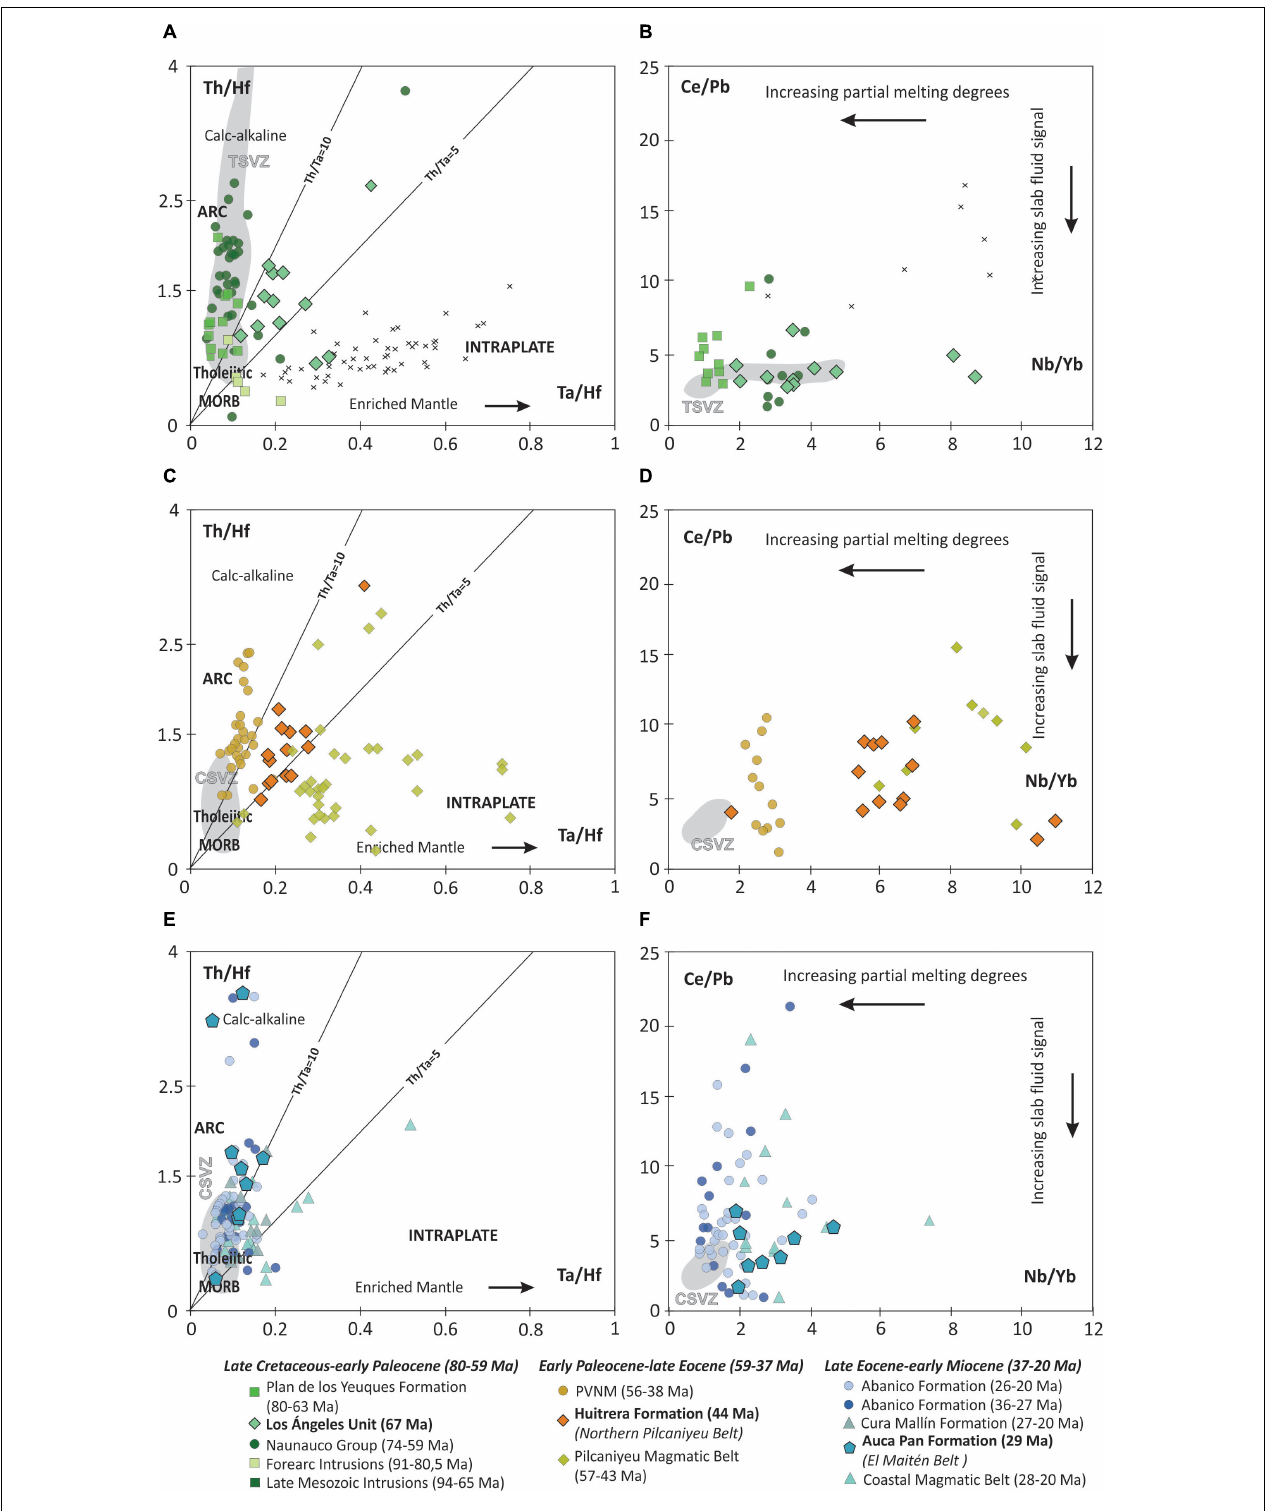
FIGURE 11 | (A,B) Th/Hf vs. Ta/Hf and Ce/Pb vs. Nb/Yb for Late Cretaceous-early Paleocene magmatic units along the Southern Central Andes. (C,D) Th/Hf vs. Ta/Hf and Ce/Pb vs. Nb/Yb for early Paleoceno-late Eocene magmatic units along the Southern Central Andes. (E,F) Th/Hf vs. Ta/Hf and Ce/Pb vs. Nb/Yb for late Eocene-early Miocene magmatic units along the Southern Central Andes. Gray crosses correspond to the Neogene Main and Post-Plateau lavas from Patagonia retroarc (Gorring and Kay, 2001; Guivel et al., 2006). For references to the data sources, see details in the text (references in section Compiled Arc-Like Andean Dataset). TSVZ corresponds to the Transitional Southern Volcanic Zone (34.5–38 ◦ S) while CSVZ corresponds to the Central Southern Volcanic Zone (38–43 ◦ S) (references in section Compiled Arc-Like Andean Dataset). Frontiers in Earth Science |